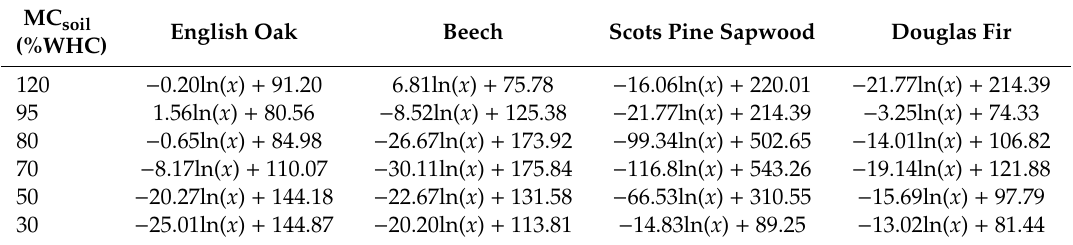
Table 5. Regression functions for fitting curves shown in Figure 5 ( y = wood moisture content MC wood ; x = water holding capacity